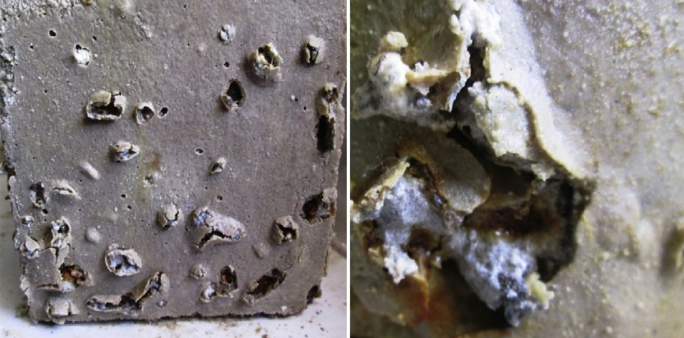
Figure 13. Expansion of hardened paste caused by SS aggregate [91].